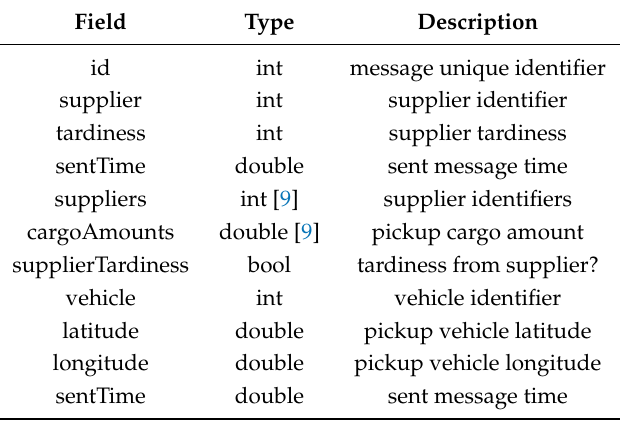
Table 3. DMRVR message